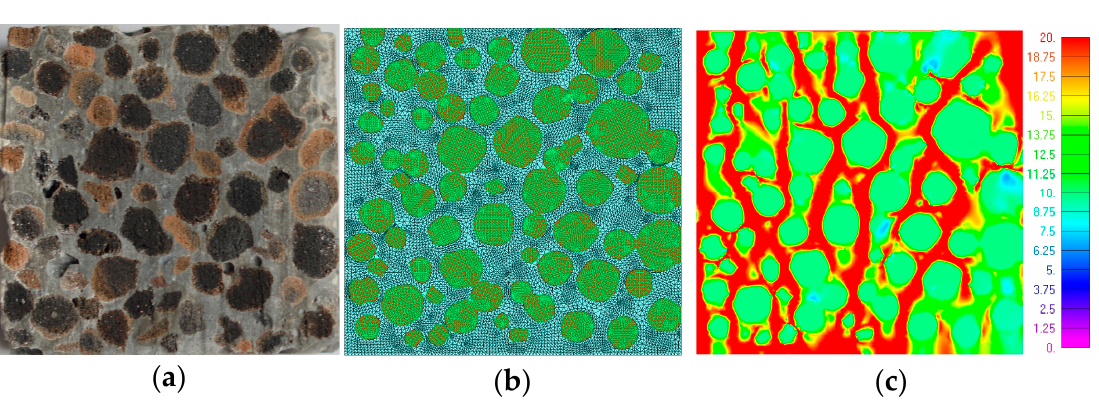
Figure 9. Specimen LWC 1: ( a ) section; ( b ) finite element method (FEM) model; and ( c ) FEM results [MPa].